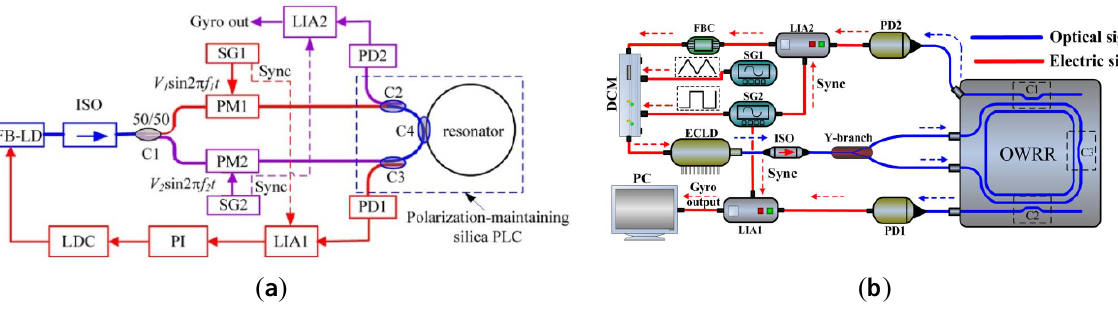
Figure 19. The circuits of RMOG. ( a ) Zhejiang University. ( b ) Beihang